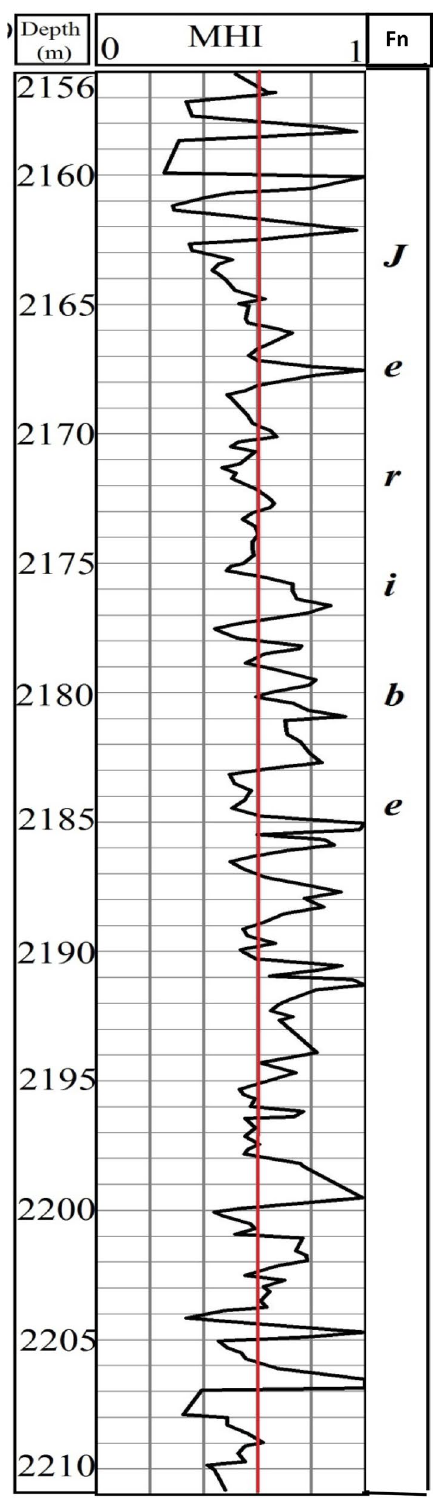
Fig. 6 Movable Hydrocarbon Index (MHI) curve for the studied Jeribe Formation in the well Ja-49. The red line represents 0.6 MHI value separating movable hydrocarbon zones (≤ 0.6) from non-mova- ble hydrocarbon zones (>